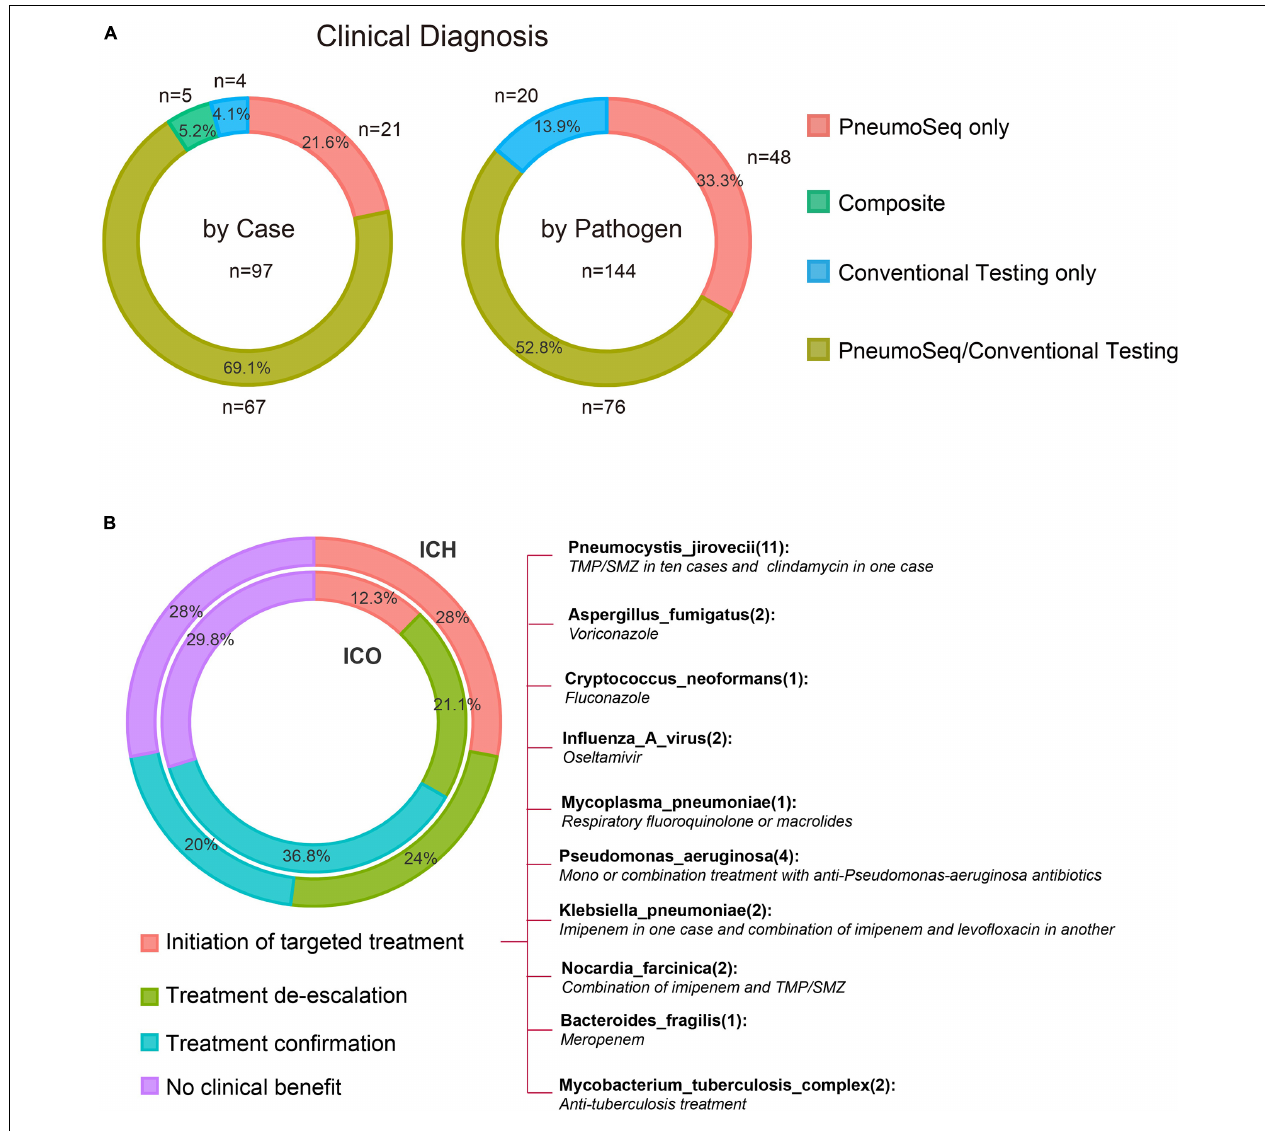
FIGURE 6 | Diagnostic performance and the real-world clinical impact of PneumoSeq. (A) Agreement between clinical diagnosis and testing results. Analyses were performed in 97 patients whose microbial etiology was diagnosed clinically, involving a total of 144 pathogens. PneumoSeq/Conventional Testing, pathogens identified by both methods in agreement with clinical diagnosis; Composite, pathogens identified by combining PneumoSeq and the conventional testing results; PneumoSeq Only and Conventional Testing Only, pathogens identified by an only single method. Left panel, by case; Right panel, by microorganism. (B) Evaluation of the clinical impact of PneumoSeq in ICO and ICH patients. Inner circle, ICO; Outer circle, ICH. The clinical impact was assessed as 1 of the 4 categories indicated with different